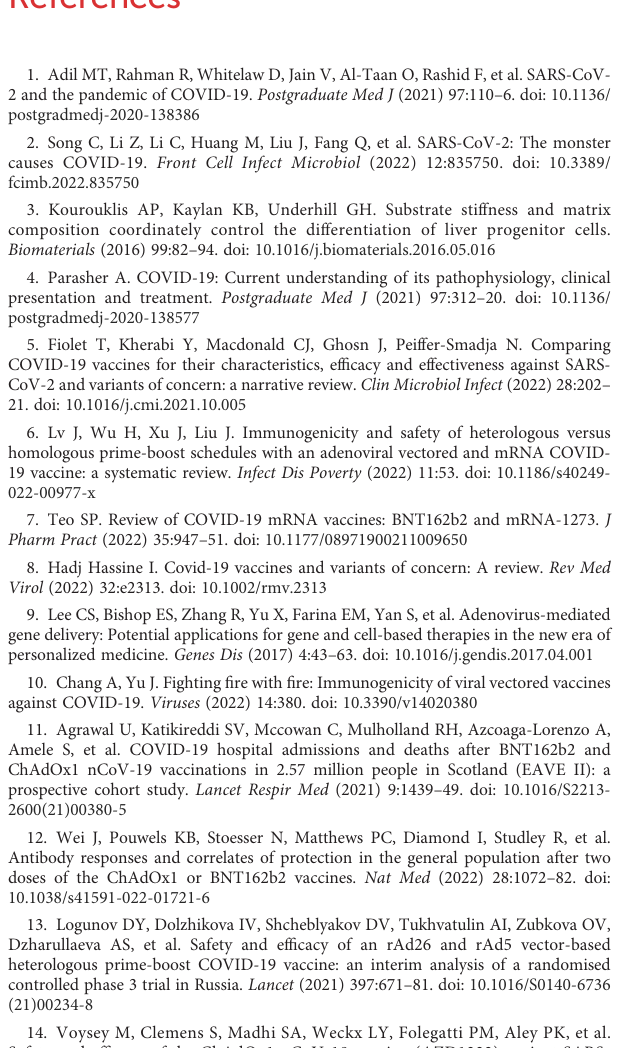
SUPPLEMENTARY TABLE 1 List of features in three immune cell types sorted by LASSO, LightGBM, mRMR, MCFS, and PFI methods.